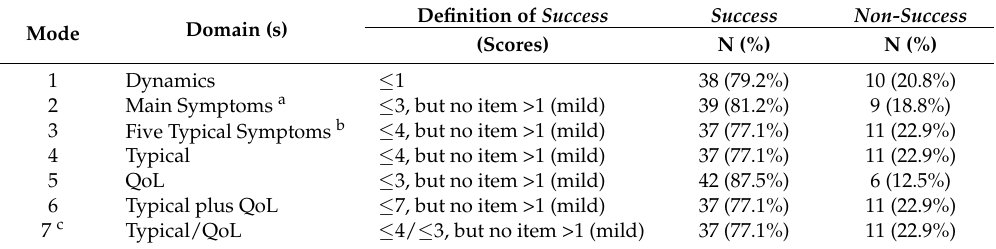
Table 6. Various possibilities to differentiate between Success and Non-success in 48 female patients treated for acute uncomplicated cystitis using part B of the ACSS. QoL = Quality of Life;